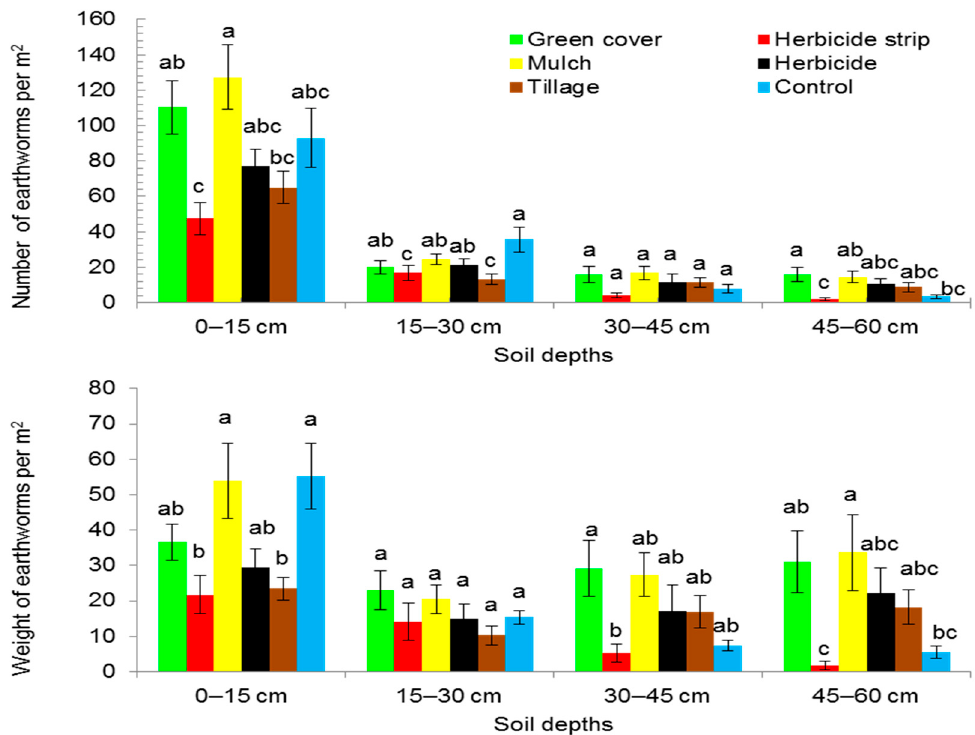
Figure 4. Earthworm abundance and their biomass at different soil depths per m 2 according to different soil management practices during the last year of the trial. Different letters denote significant differences among soil management practices in each depth ( p ≤ 0.05), error bars are standard errors.